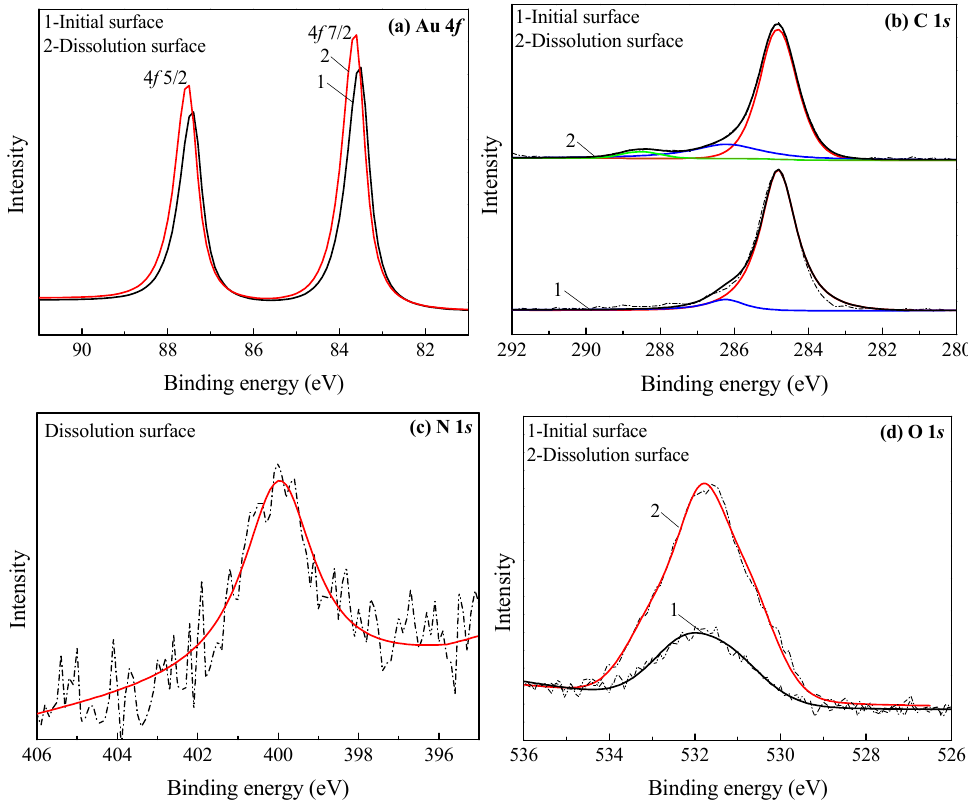
Figure 12. High-resolution XPS spectrum of Au 4 f ( a ), C 1 s ( b ), N 1 s ( c ), and O 1 s ( d ). The high resolution XPS spectra of C 1 s on the surface of original and reagent-treated sensors are shown in Figure 12b. According to the graph, the main peak of C 1 s was at